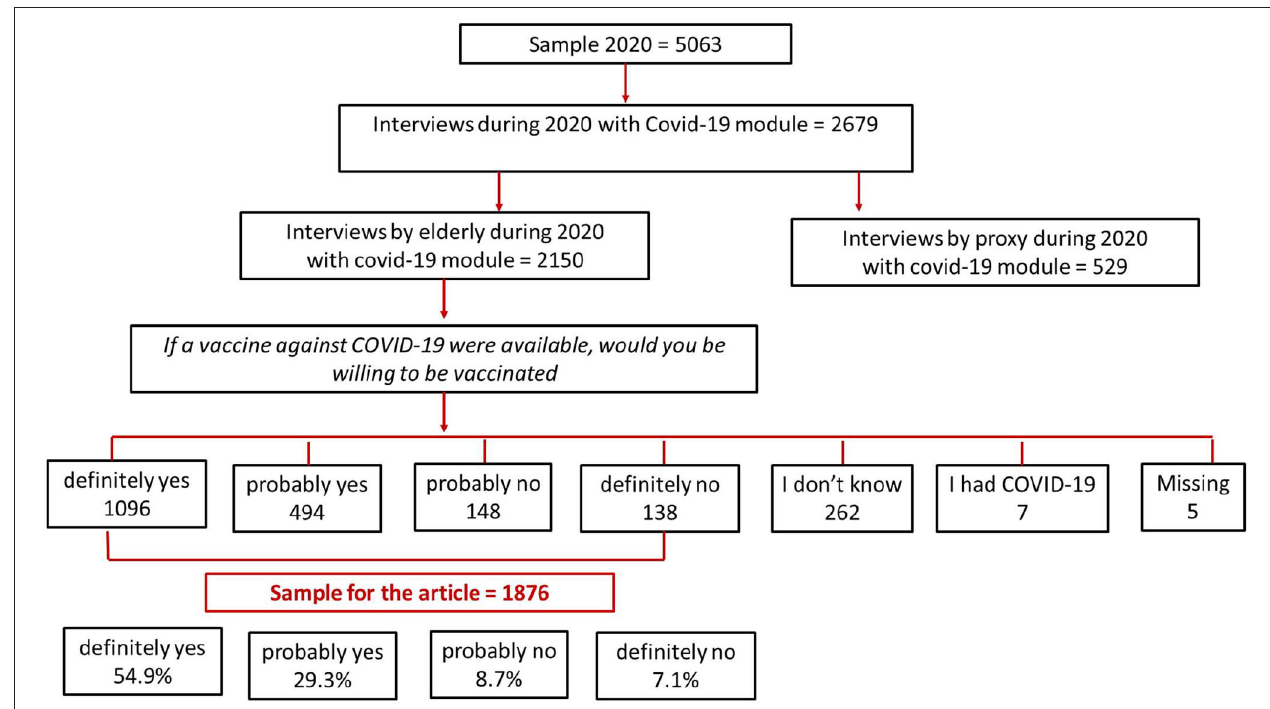
FIGURE 1 | Flow chart for selected sample. Passi D’Argento, Italy, August-December